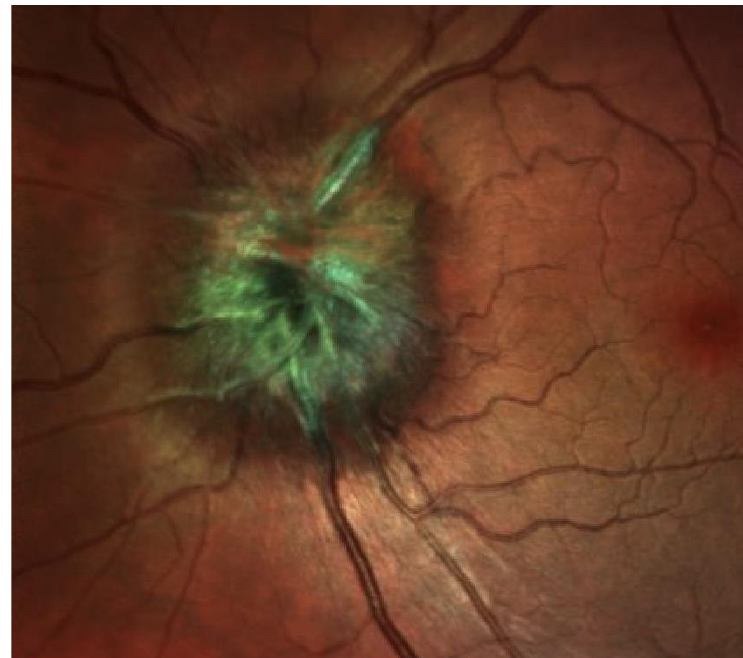
Figure 9. Melanocytoma.